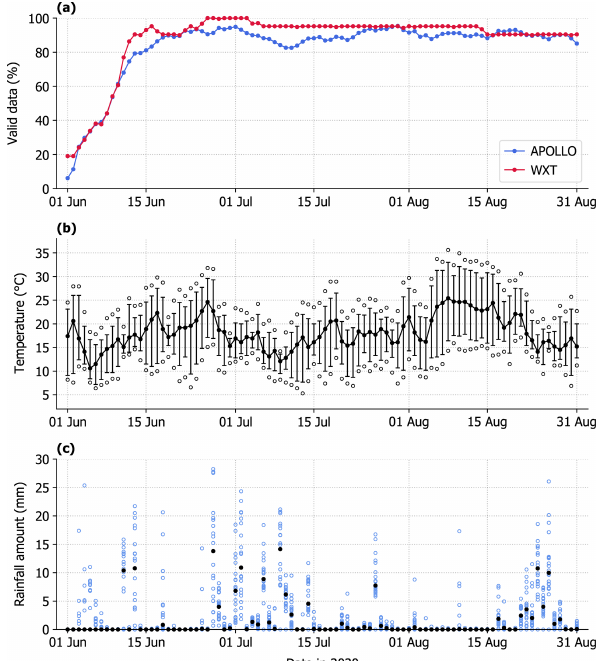
Figure 7. FESST@HH level 2 data from 1 June to 31 August 2020: (a) daily mean fraction of valid temperature observations over all APOLLO and WXT stations; (b) daily median (filled dots), 5th per- centile and 95th percentile (whiskers), and minimum and maximum (open circles) of all WXT air temperature observations; and (c) in- dividual accumulated rainfall amount at all WXT stations (open cir- cles). Filled dots mark the daily median. Days are defined in UTC.